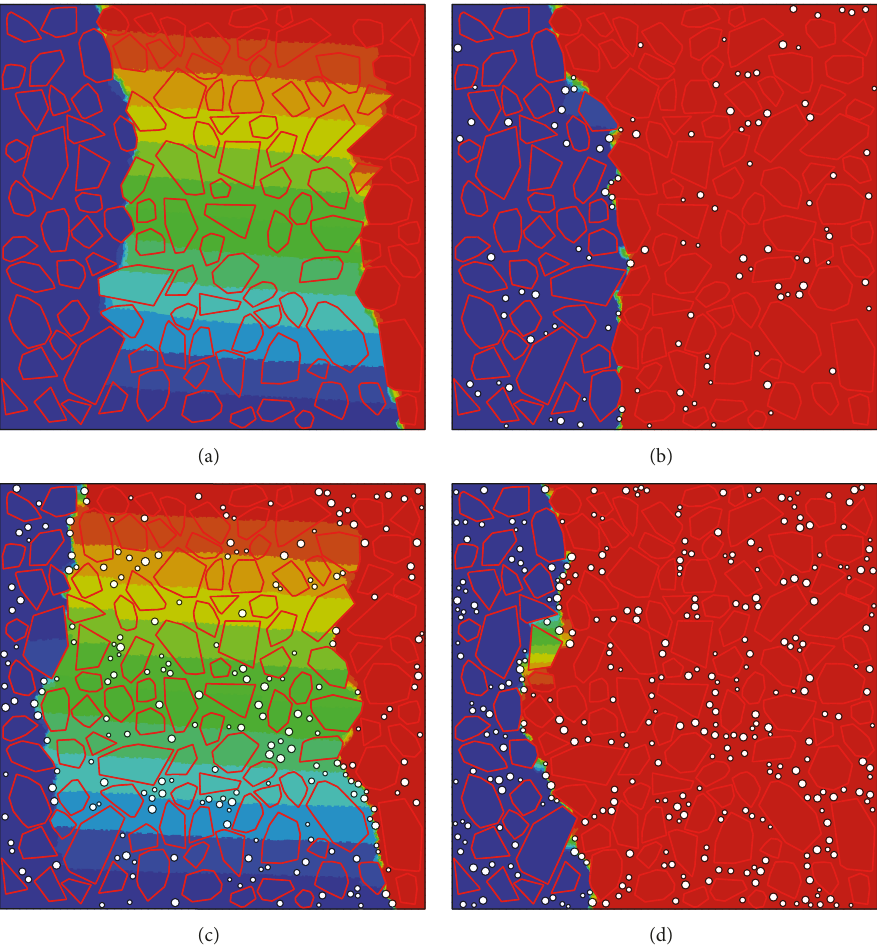
Figure 15: Fracture patterns of concrete specimens with 𝐴 𝐹 = 50 % for (a) 𝐴 V = 0 %; (b) 𝐴 V = 2 %; (c) 𝐴 V = 4 %; (d) 𝐴 V = 6